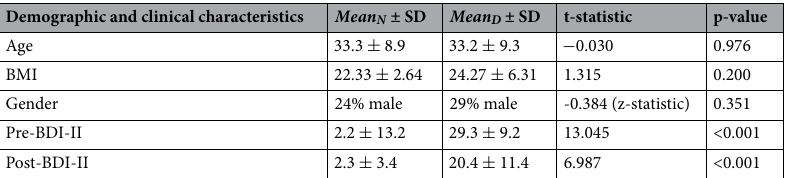
Demographic and clinical characteristics